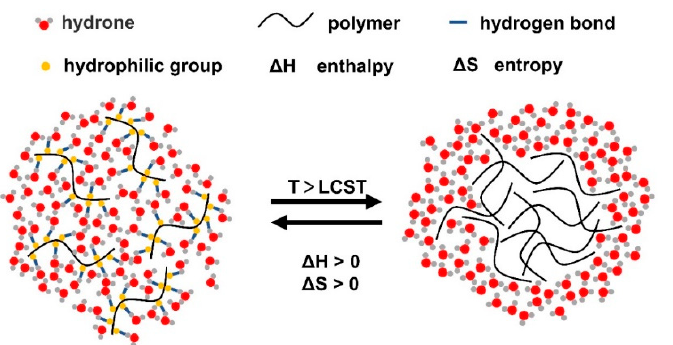
Figure 1. Schematic of thermoresponsive hydrogels (LCST hydrogels). With the increase in tem- perature, the hydrogen bond force between polymers and water molecules is weakened, and the hydrophobic effect is enhanced, forming the hydrogel.